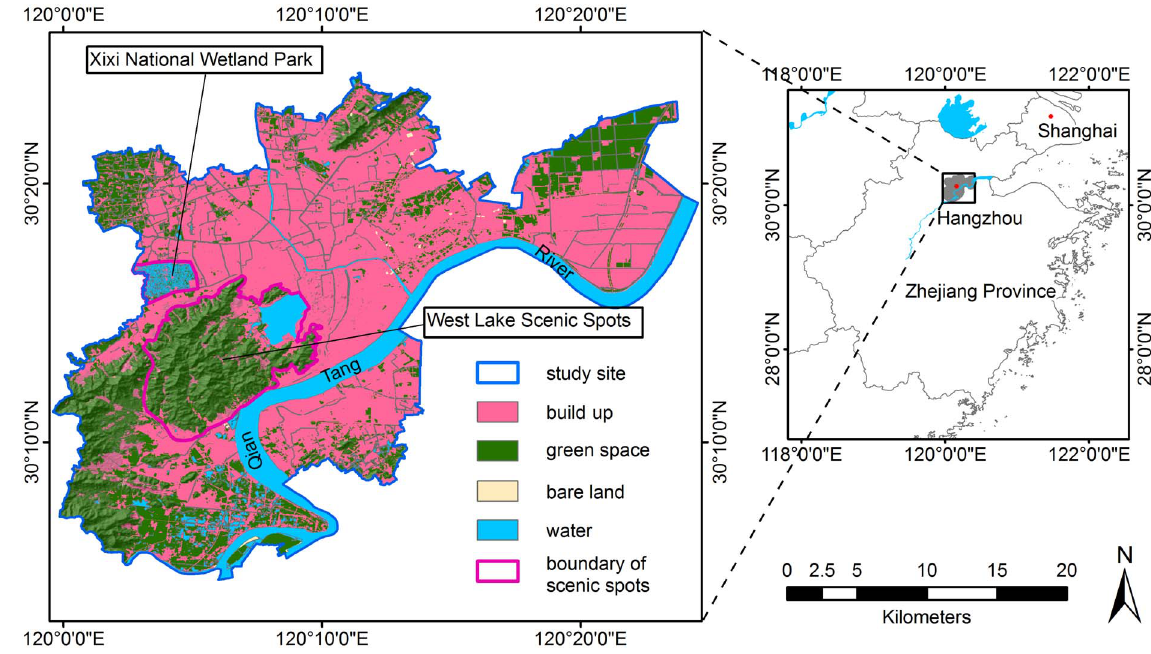
Figure 1. A map of the study area, i.e., Hangzhou city proper.